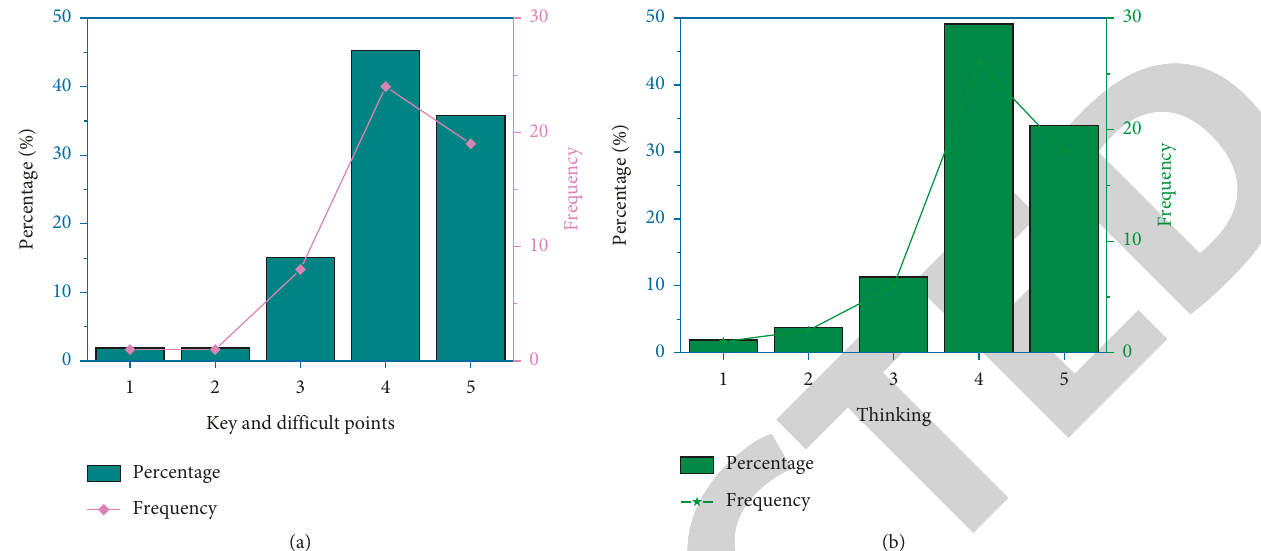
Figure 5: Percentage of understanding key and difficult points and having positive thinking after multimedia-assisted teaching. (a) Key and difficult points. (b) Thinking.